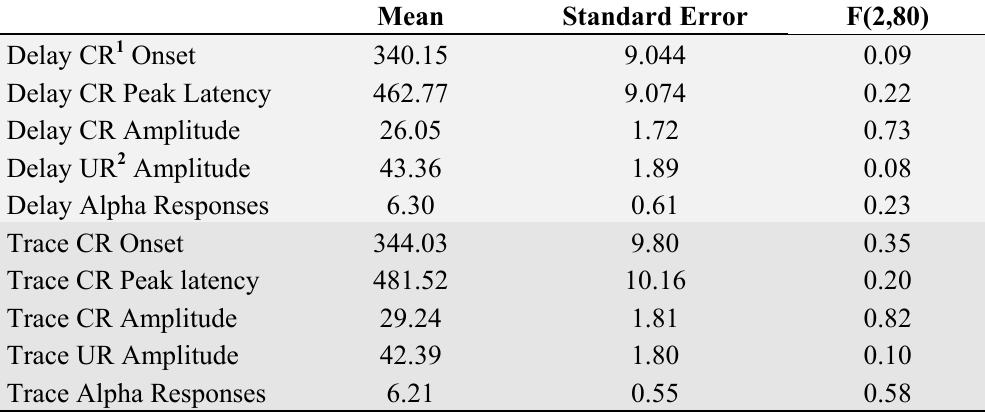
Table 5. Summary statistics for secondary eyeblink conditioning measures (n =